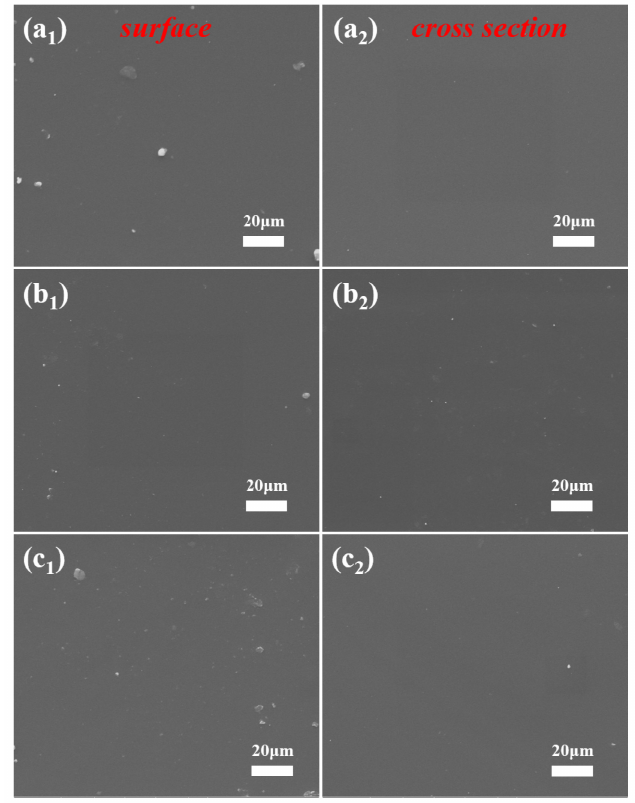
Figure 2. Surface and cross-section SEM images of polydimethylsiloxane (PDMS) frameworks of the ( a 1 , a 2 ) pure sample, ( b 1 , b 2 ) 1P1S sample, and ( c 1 , c 2 ) 1P2S